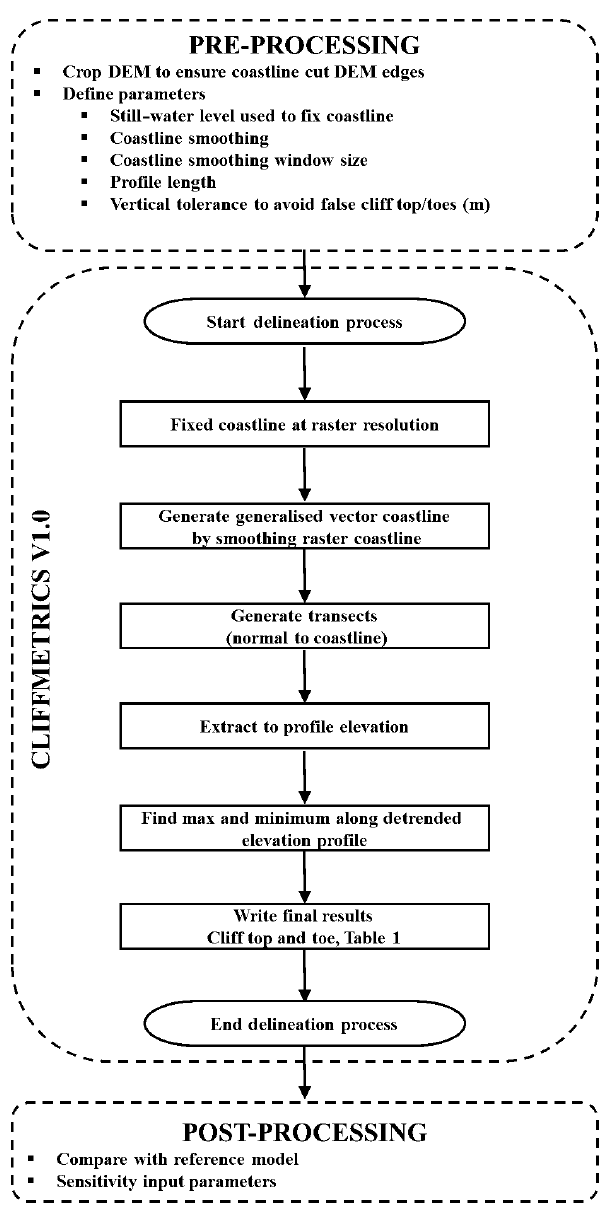
Figure 3. Flow chart of the proposed automatic delineation algo-